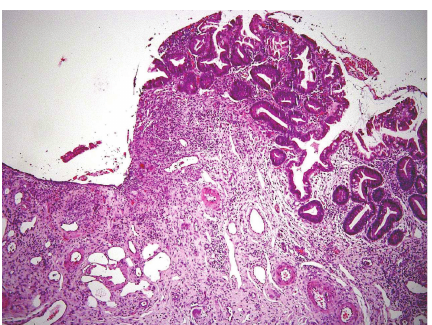
Figure 3: Microscopic examination (hematoxylin-eosin, x150) of the operative specimen. Ulcerative ileitis, the mucosa is replaced by a granulation tissue.